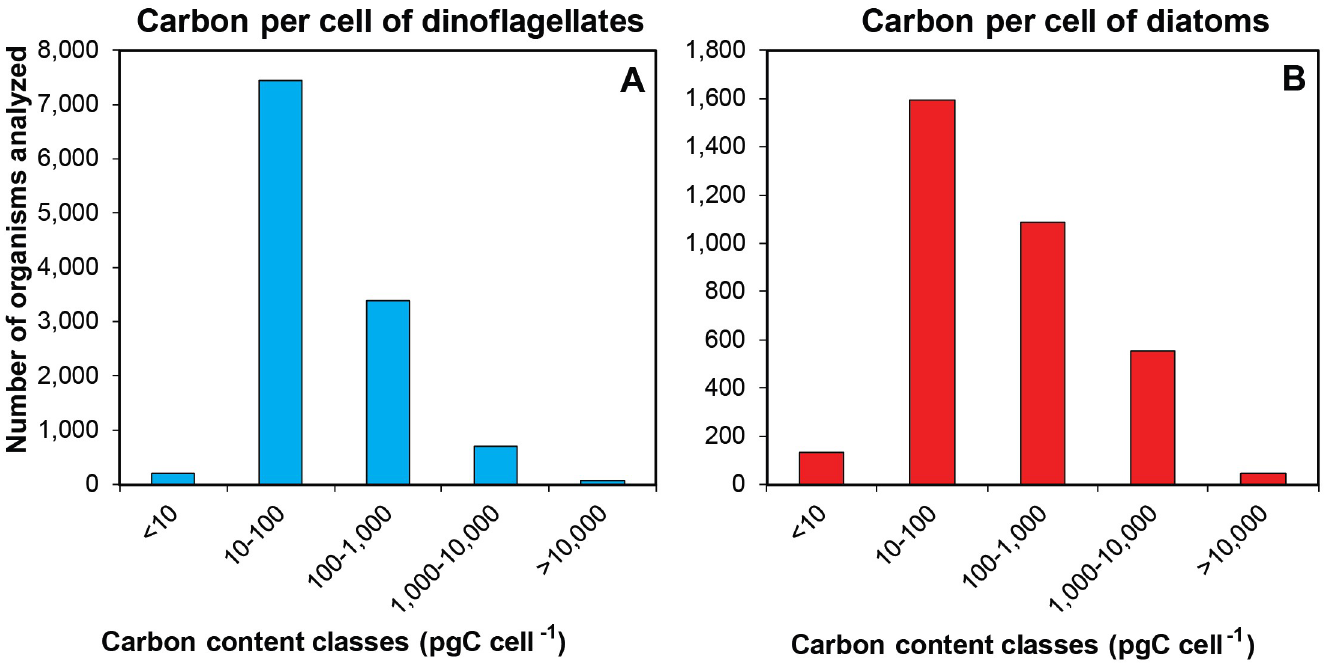
Fig 5. Distribution of carbon content per cell (pg C cell -1 ) of two phytoplankton groups. Frequency histograms of carbon content per cell (pg C cell -1 ) estimated from cell biovolume calculations for genera of (A) dinoflagellates (blue bars) and (B) diatoms (red bars). Five carbon classes are indicated at the X-axis of both groups.